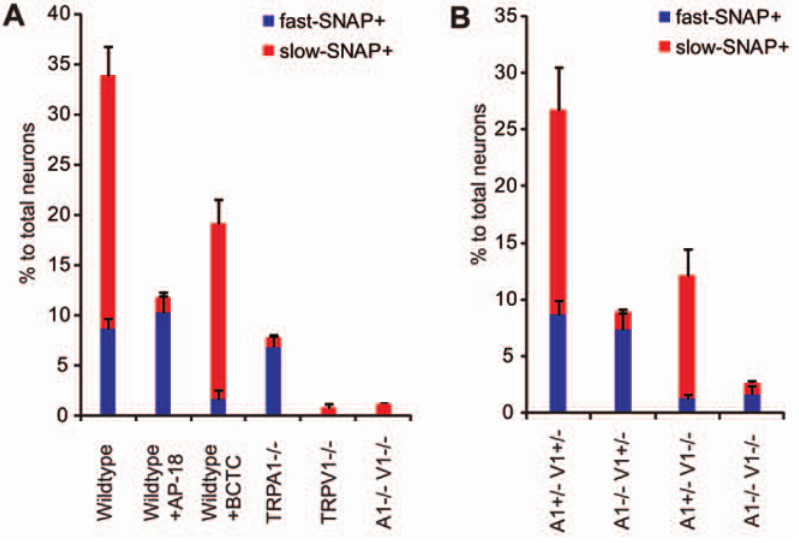
Figure 4. NO donor activates DRG neurons via TRPV1 and TRPA1. Proportion (%) of neurons activated by SNAP (3 mM) is shown and characterized as fast-SNAP + (blue) and slow-SNAP + (red) in different genetic backgrounds (e.g., A1 2 / 2 V1 2 / 2 represents TRPA1 2 / 2 TRPV1 2 / 2 ) and treatments. (A) DRG neurons were challenged with SNAP (3 mM) for 5 min, followed by capsaicin (Caps, 10 m M), mustard oil (MO, 0.5 mM), and/or ATP (100 m M) as controls (n $ 4 each, see Table 1 for quantitation). AP-18 (100 m M) and BCTC (1 m M) were applied 3 min prior to SNAP application. (B) DRG neurons were first pretreated with forskolin (100 m M) and m-3M3FBS (50 m M) for 10 min, followed by the same protocol as (A). (n $ 7 each, see Table 2 for quantitation). Haploinsufficiency has been reported for TRPA1 [58–59] when monitoring certain phenotypes and may influence the proportion of slow-SNAP + neurons observed in our cultures.